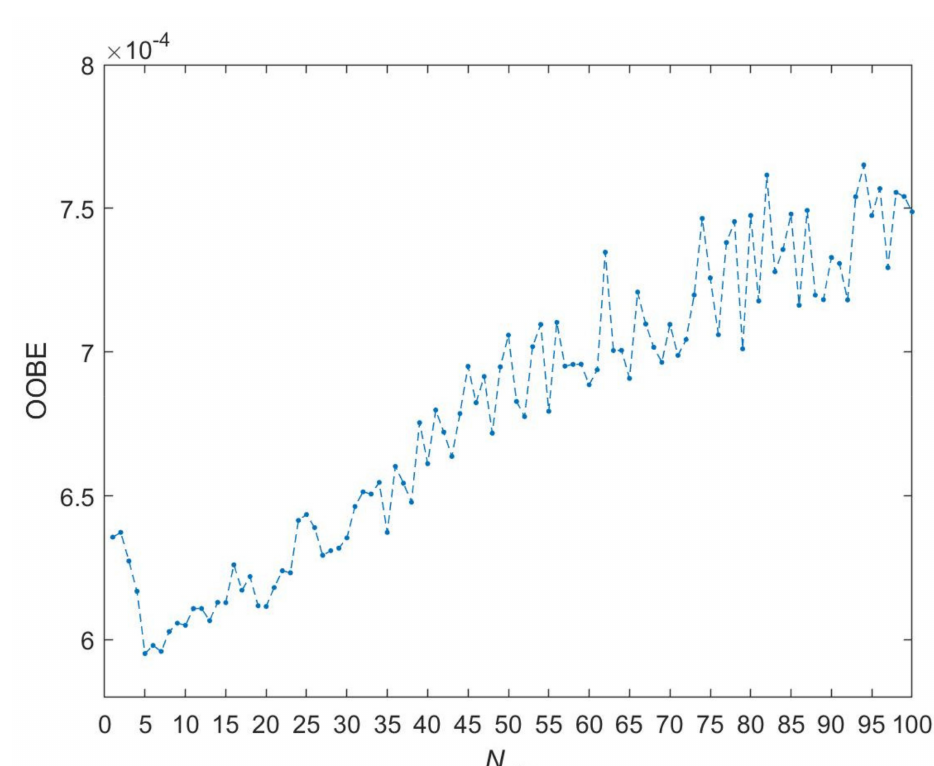
Figure 5. Variation of the OOBE with the N obs increasing from 1 to